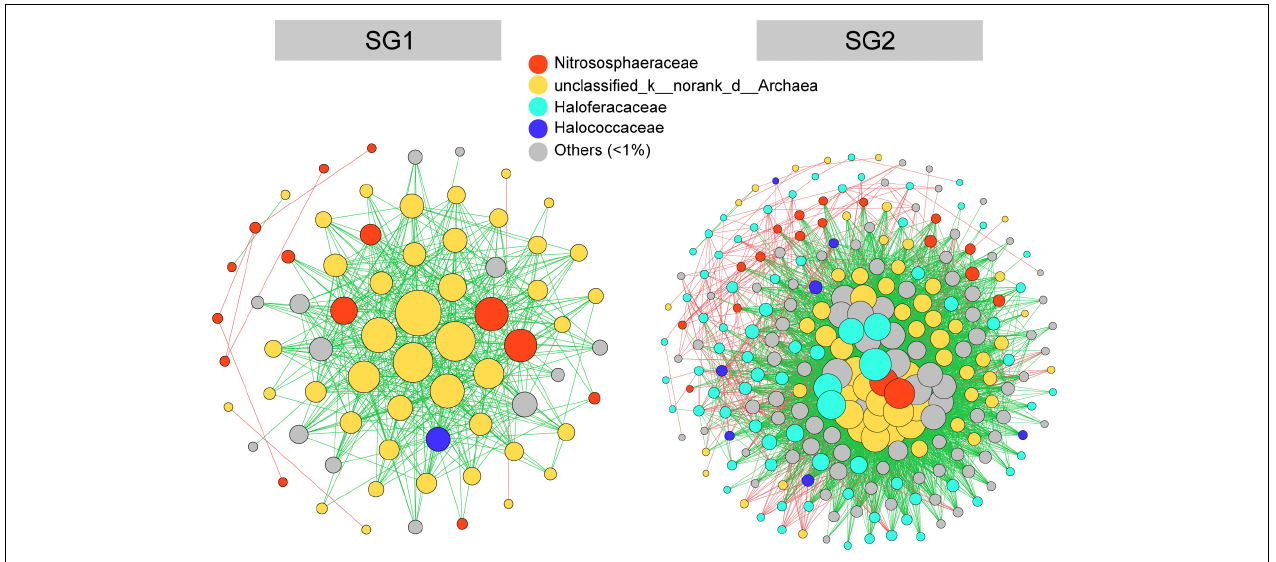
FIGURE 6 | Co-occurrence network of microbiomes in SG1 and SG2. The size of each node was proportional to the degree of the operational taxonomic units. Node color was based on phylum taxa. The connection (edge) colored with red and green represented coexistence and mutual exclusion, respectively.